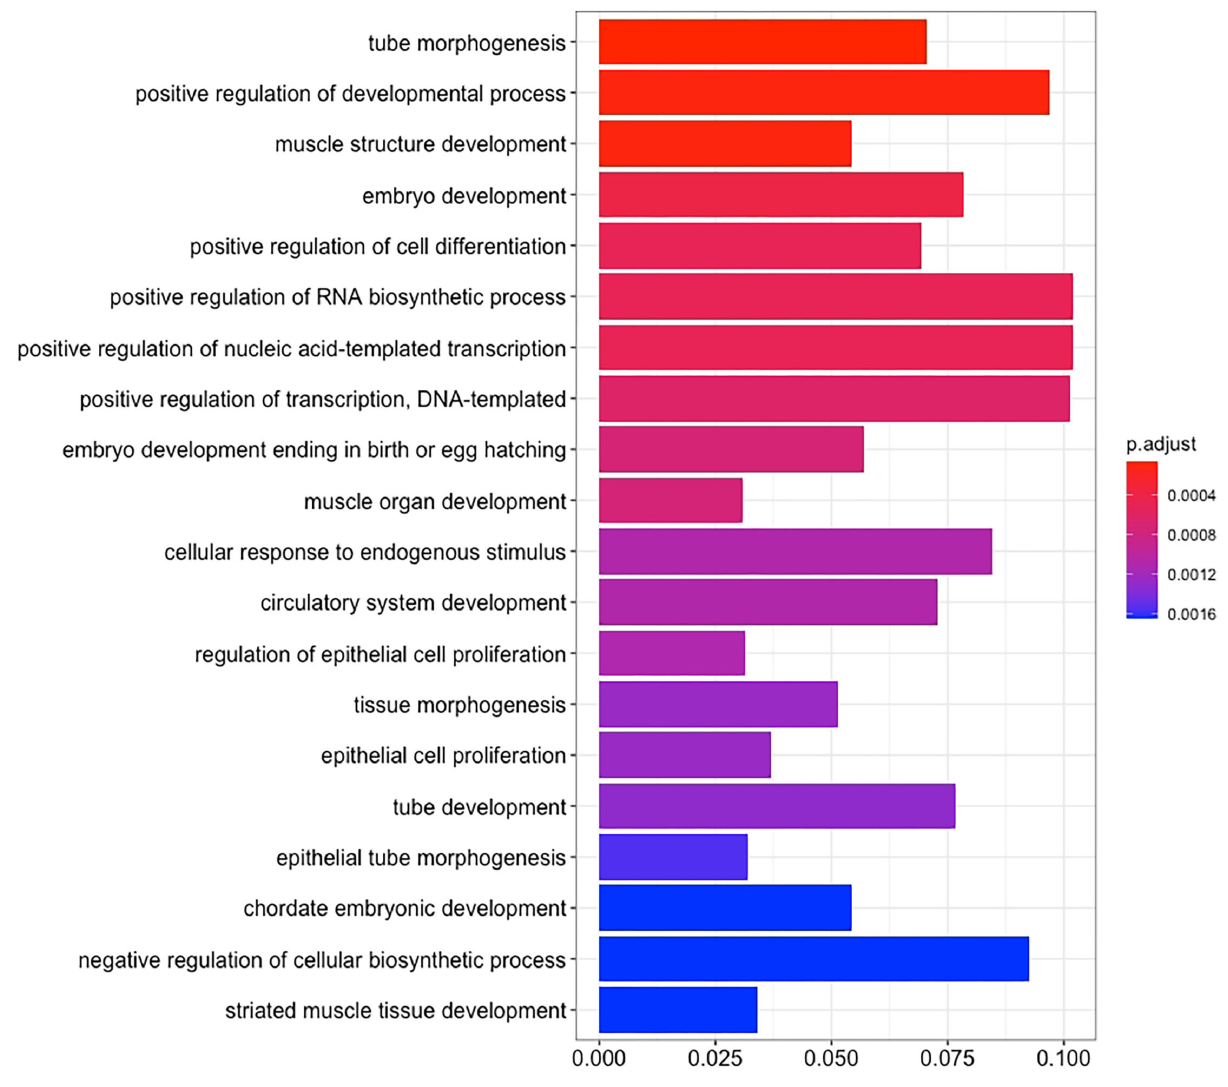
FIGURE 5 | The enrichment maps of KEGG pathways were analyzed from 14